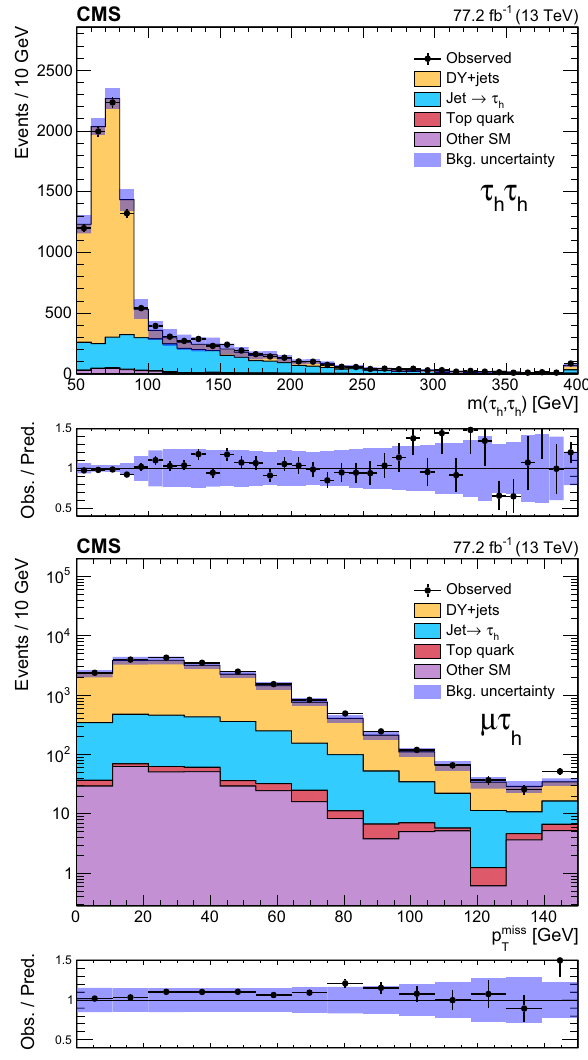
τ Fig. 4 Visible-massspectraof τ leptonpairsin τ events(upper)and h h p miss distribution in μτ events (lower) in data and the corresponding h T prediction for SM background in the combined 2016 and 2017 DY+jets validation regions. The last bin includes overflow events in each case. The shaded uncertainty band represents the statistical and systematic uncertainties in the background prediction. For the μτ distribution, h the systematic uncertainty included in each bin corresponds to a single common average